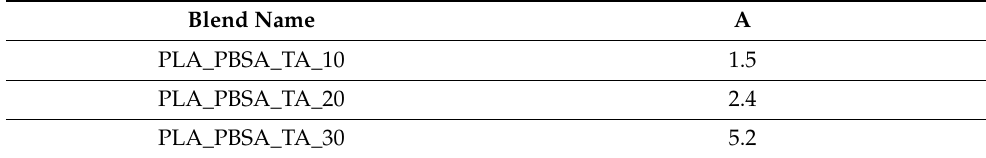
Table 4. Bran composites adhesion factor calculated according Equation (8) at room temperature (25 ◦ C). Blend Name